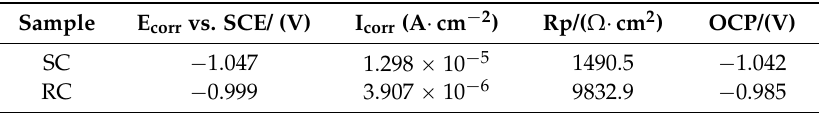
Figure 4. Potentiodynamic polarization curves of Sn–8Zn–3Bi solder alloy with two cooling rates in 3.5 wt.% NaCl solution. Table 1. Corrosion parameters of the studied Sn–8Zn–3Bi solder in 3.5 wt.% NaCl solution at room temperature.